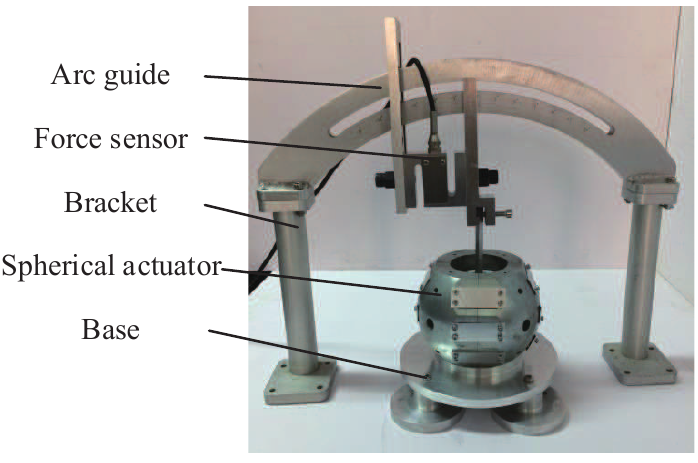
Figure 12. Experimental testbed for the measurement of output torque.